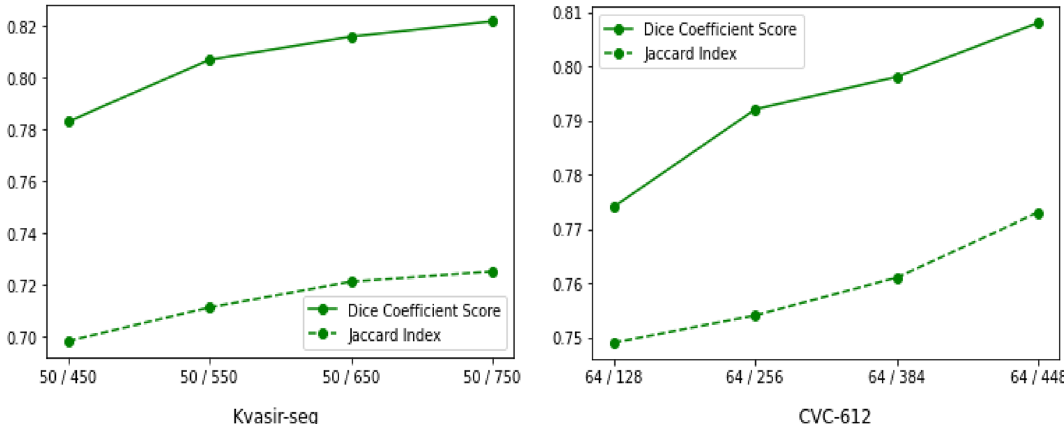
Figure 5. Results on the testing subset of both Kvasir-SEG and CVC-612 dataset with fixed number of labeled and different number of unlabeled images.